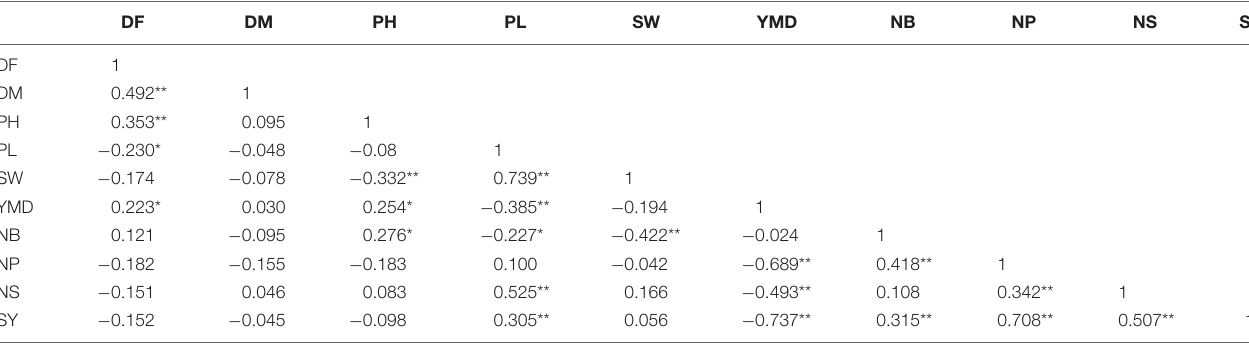
TABLE 1 | Correlation coefficients for various quantitative characters in mung